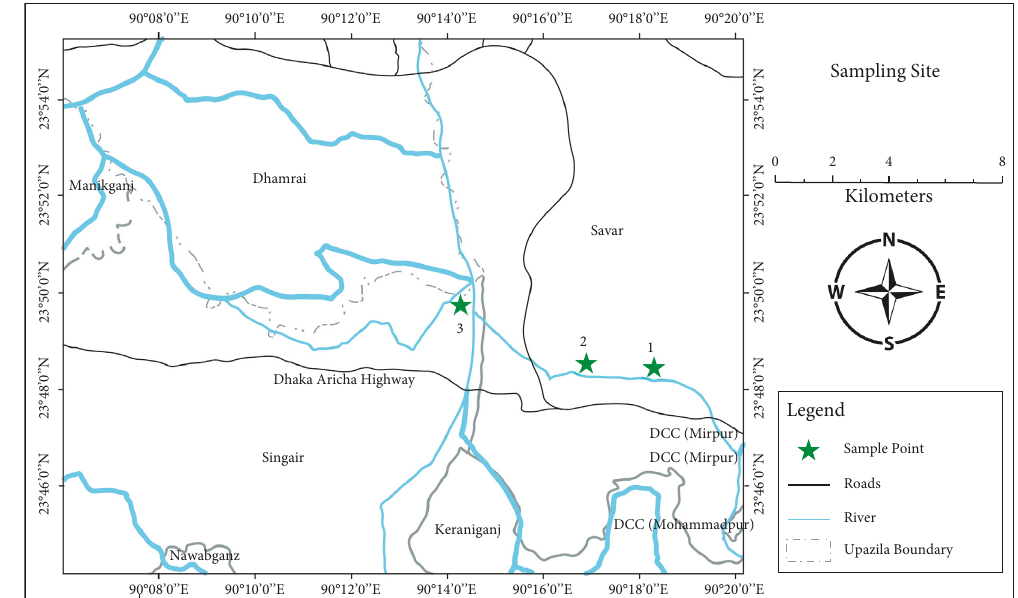
Figure 1: Location of sampling site. Table 1: Characteristics of the soils and OM used in the experiment.